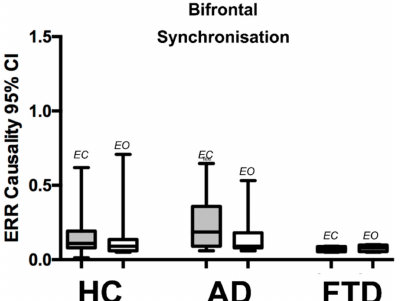
Figure 5. QEEG bi-frontal synchronization, group comparison between AD & HC. This graph depicts the median with 95% CI bi-frontal (F3–F7 to F4–F8) synchronization for Eyes Closed (EC) and Eyes Open (EO) states from three groups; HC-Healthy Controls ( n = 20), AD—Alzheimer’s disease ( n = 20), FTD—Fronto-Temporal Dementia ( n = 4). The graph shows no significant differences in the degree of synchronization measurements for each group and, additionally, for each state (i.e., EO & EC), there is no difference within each